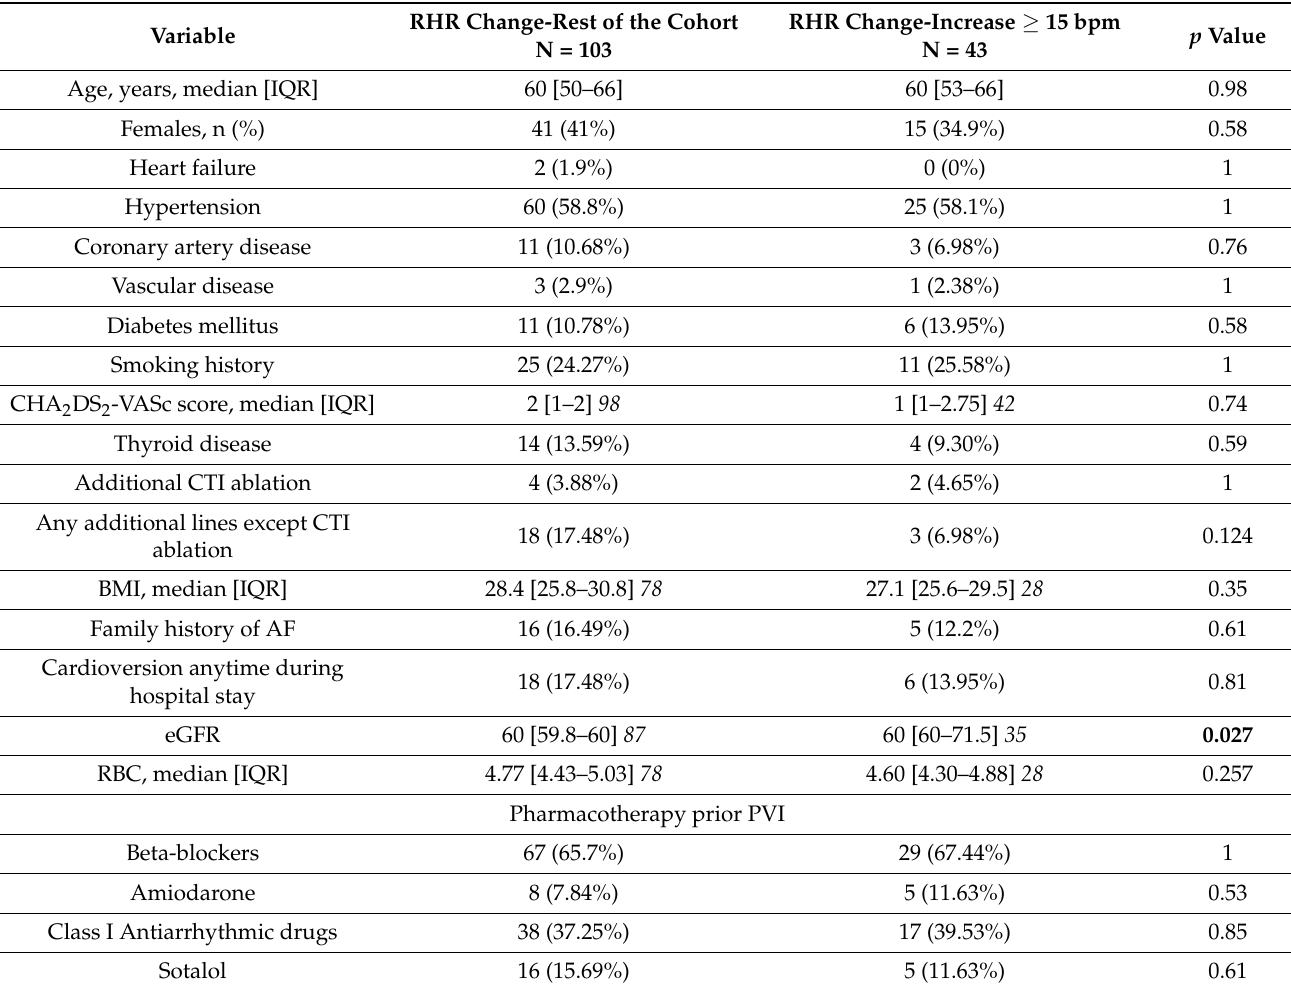
Table 2. Baseline characteristics of the groups according to change in